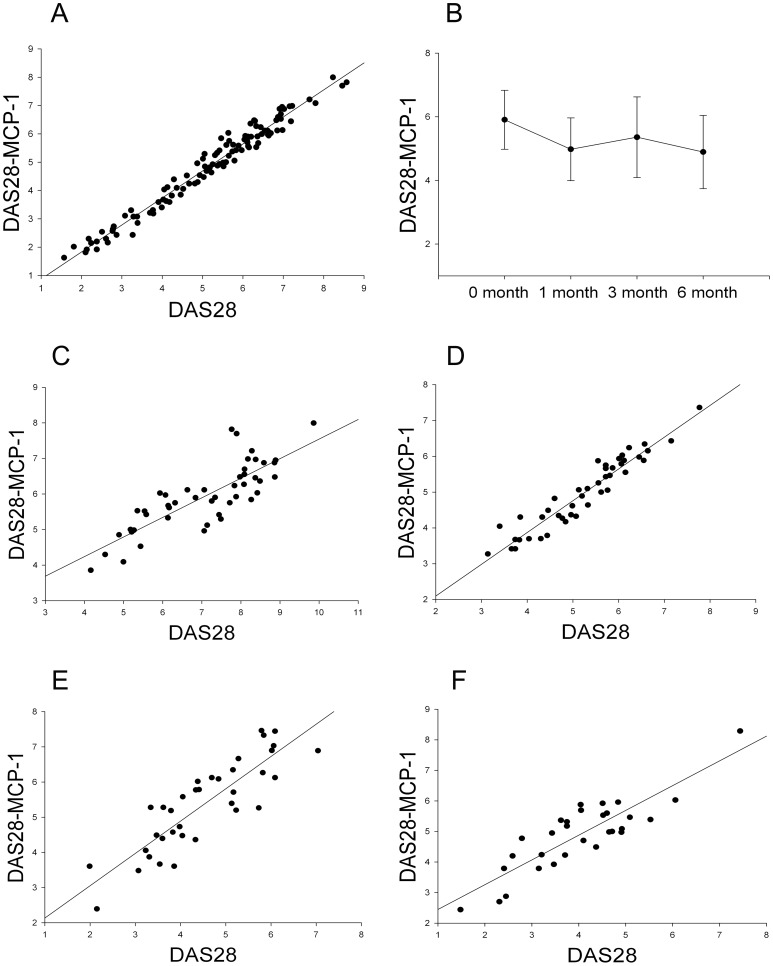
Performance and correlation of DAS28-MCP-1 with DAS28.Correlation analysis was performed by estimating Pearson’s correlation coefficients for 111 patients with rheumatoid arthritis, including 48 newly diagnosed (blood drawn four times in a 6-month period) patients and 63 patients undergoing standard treatment (blood drawn only once). (A) Overall correlation between DAS28-MCP-1 and DAS28 (48 newly diagnosed patients at 0 months plus 63 patients) (r  = 0.984 and P<0.001). (B) Change in DAS28-MCP-1 during a 6-month period was assessed by ANOVA and post-hoc LSD test. The P-values were <0.001, 0.022, and <0.001 for the comparison of 0 (n  = 48) months, with 1 (n  = 44), 3 (n  = 36), and 6 months (n  = 30), respectively. Values were expressed as mean ± SD. (C) Correlation between DAS28 and DAS28-MCP-1 at 0 months among newly diagnosed patients (r  = 0.944 and P<0.001). (D) Correlation between DAS28 and DAS28-MCP-1 at 1 months among newly diagnosed patients (r  = 0.951 and P<0.001). (E) Correlation between DAS28 and DAS28-MCP-1 at 3 months among newly diagnosed patients (r  = 0.862 and P<0.001). (F) Correlation between DAS28 and DAS28-MCP-1 at 6 months among newly diagnosed patients (r  = 0.865 and P<0.001).